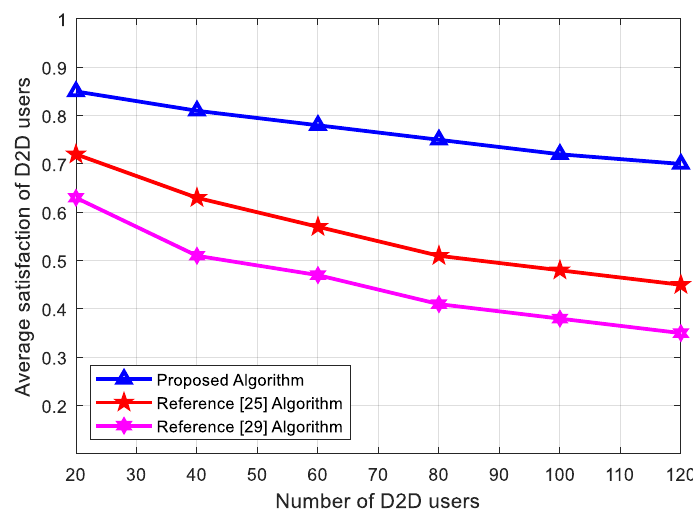
Electronics 2019 , 8 , x FOR PEER REVIEW Figure 6. Comparison of the average satisfaction of D2D users under different number of D2D users with R 0 = 10.